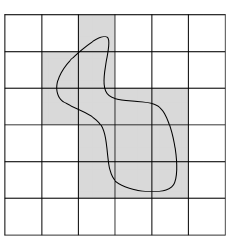
Figure 4. The concept of the coverage path planning (CPP) solution approach: ( a ) An area of interest; ( b ) a convex decomposition solution with covering directions; and ( c ) a complete coverage path, found by connecting sub-paths of sub-polygons.